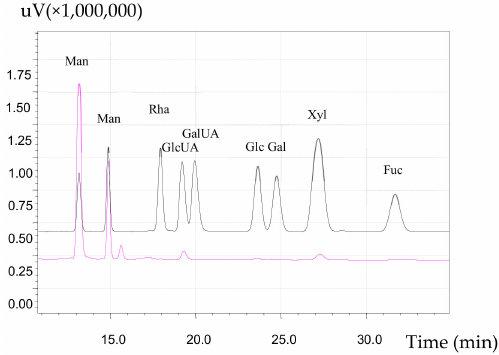
Figure 6. HPLC profiles of aAAP-1 and